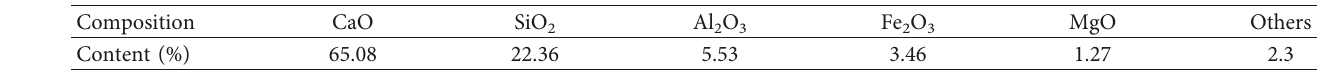
Table 2: The chemical component of cement.